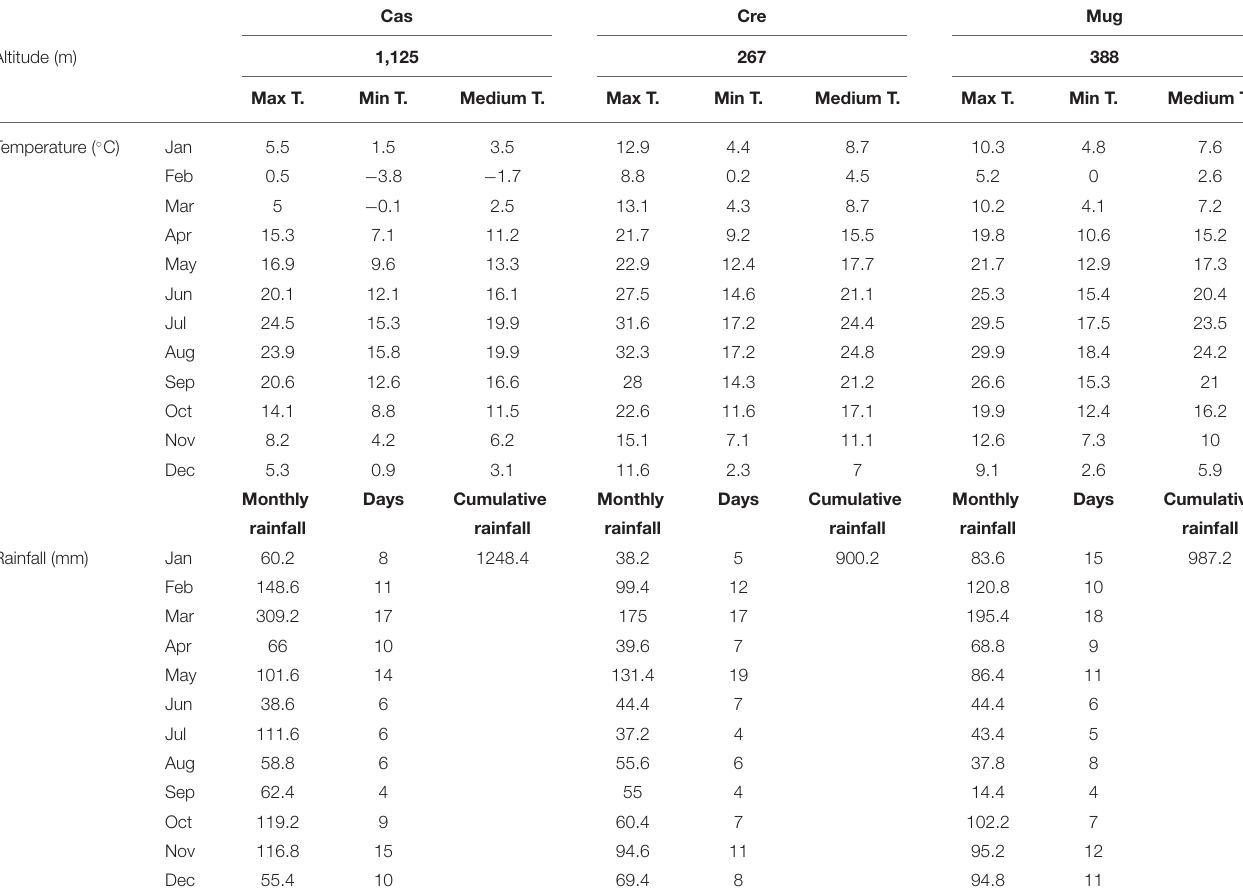
TABLE 2 | Climatic data on the fruiting bodies sampling area for the year 2018. Cas Cre Mug Altitude (m) 1,125 267 388 Max T. Min T. Medium T. Max T. Min T. Medium T. Max T. Min T. Medium T.